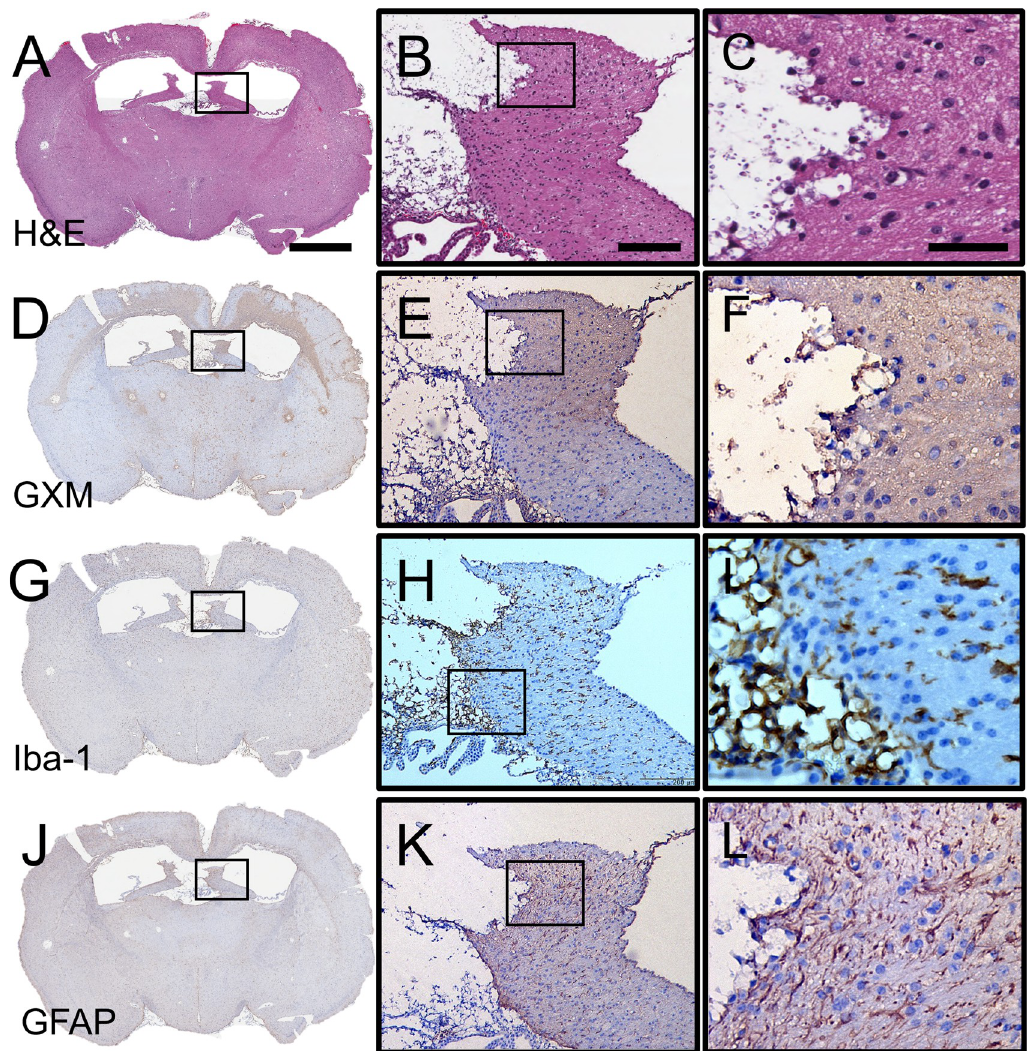
Fig 2. Cerebral cryptococcosis in mice infected in bregma. Representative coronal brain sections (scale bar: 1 mm) of bregma- infected mice stained with (A-C) hematoxylin and eosin (H&E), (D-F) C . neoformans glucuronoxylomannan (GXM)-specific monoclonal antibody (mAb) 18B7, (G-I) ionized calcium binding adaptor molecule 1 (Iba-1; microglia), and (J-L) glial fibrillary acidic protein (GFAP; astrocytes) are shown. Mouse brains were excised 7-dpi. Middle (scale bar: 100 μ m) and right (scale bar: 20 μ m) panel images are a magnification of the smaller box in the corresponding left-stained section to better show the tissue morphology, GXM distribution (brown stain), and glial cell recruitment/activation (brown stain). Five mice per infection route were evaluated to confirm all the histopathological observations reported in these